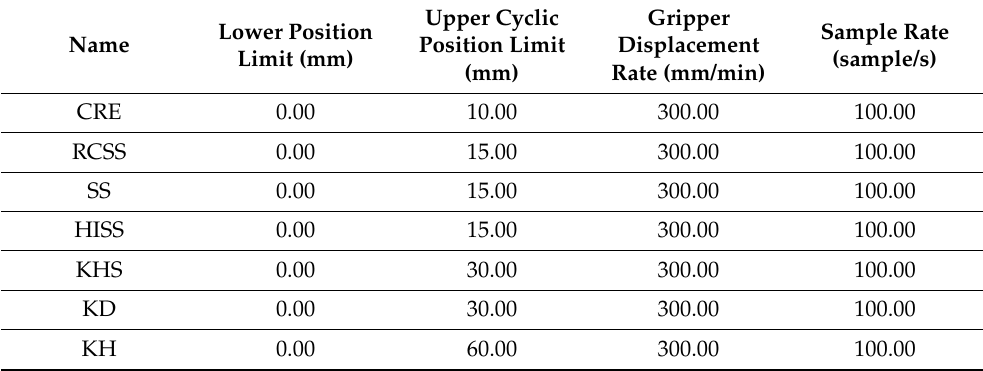
Table 2. Tensile testing parameters for each structure, where lower position limit, gripper displace- ment rate, and sample rate are constant throughout the entire testing process.